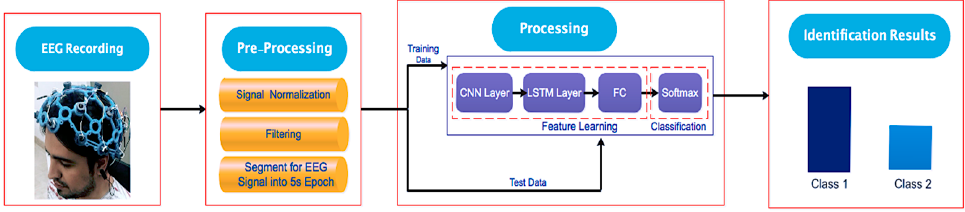
Figure 3. The block diagram for the suggested method.